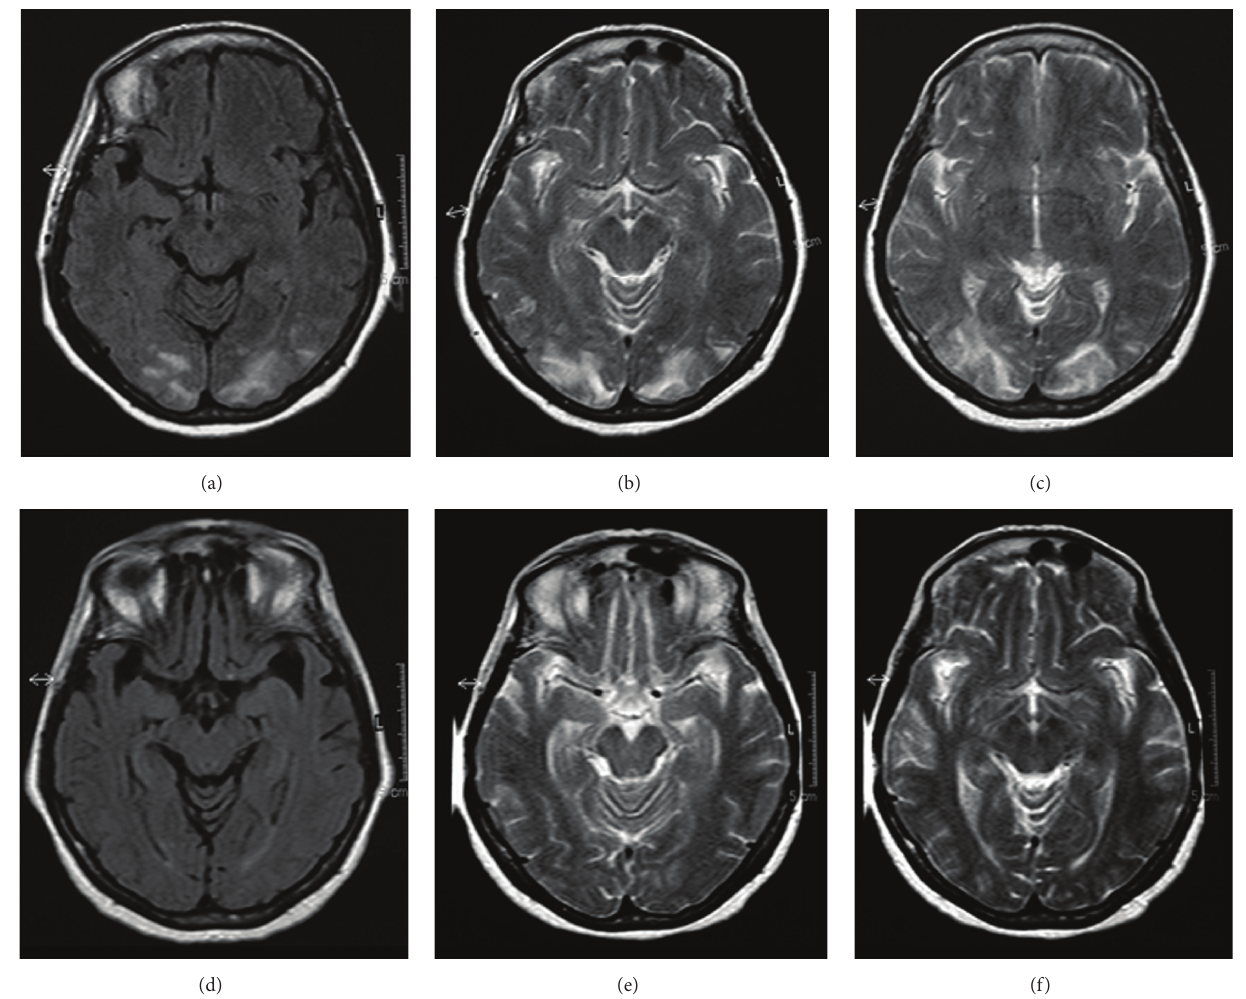
Figure 2: (a, b, c) MRI at the clinical onset of PRES. FLAIR (a) and T2-weighted (b, c) images indicate symmetric hyperintense abnormalities in the occipital lobes. (d, e, f) MRI four weeks after the clinical onset of PRES. FLAIR (d) and T2-weighted (e, f) images show regression of the occipital